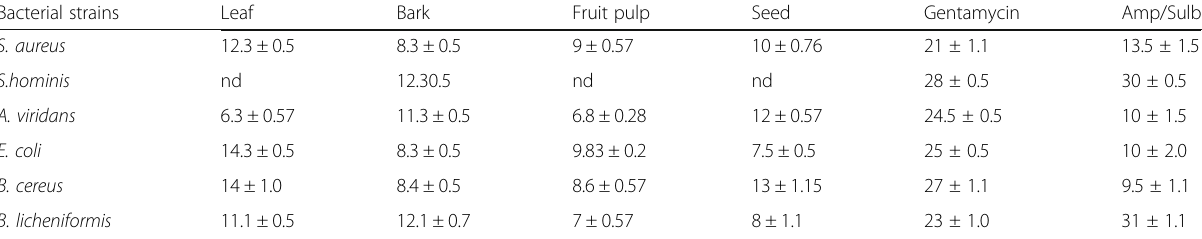
Table 4 Antibacterial activities of leaf, bark, fruit pulp and seed methanol extracts of S. caryophyllatum Bacterial strains Leaf Bark Fruit pulp